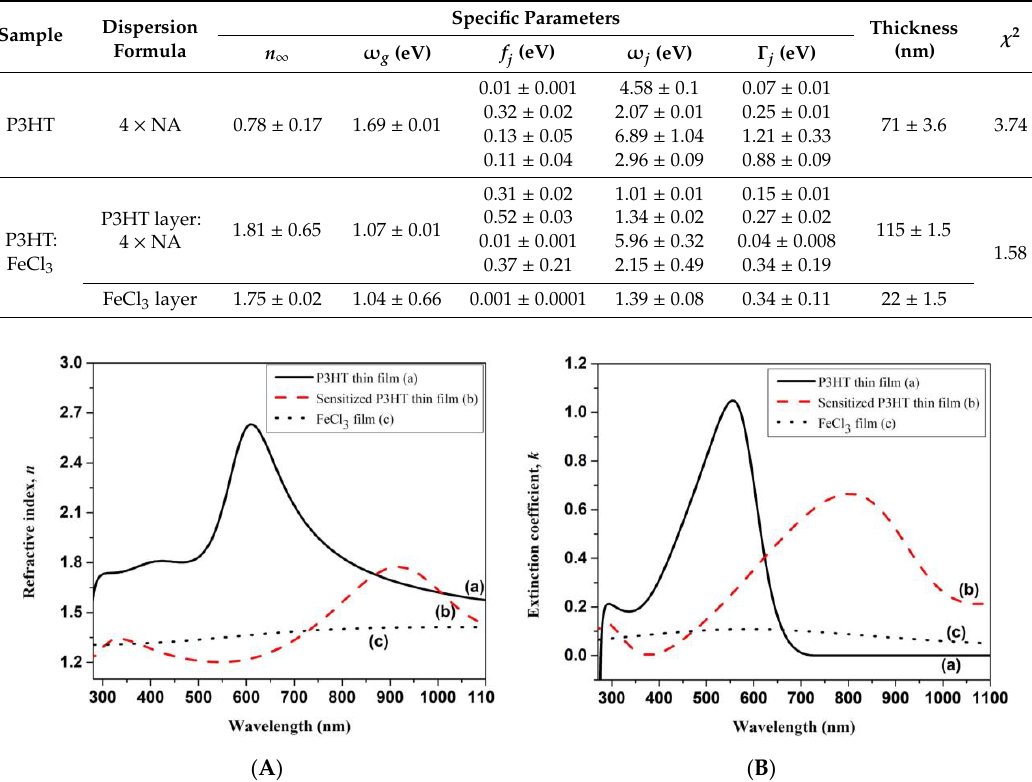
Figure 4. ( A ) Refractive index; (B) extinction coefficient.